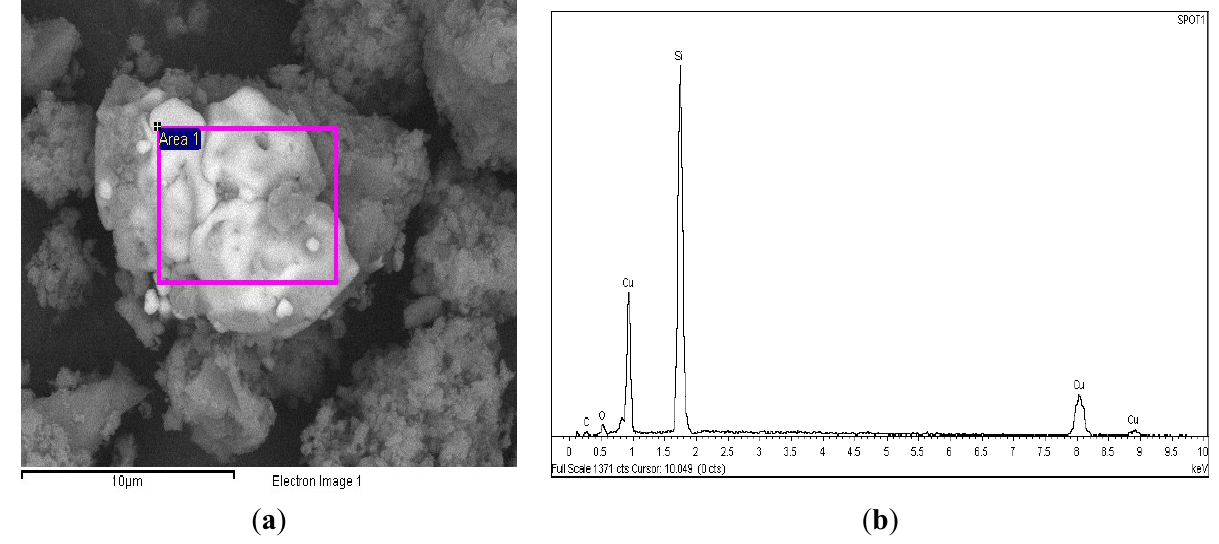
Figure 3. SEM-EDX analysis for a typical Cu-PS powder sample. ( a ) SEM micrograpgh; ( b ) EDX spectrum of the boxed area in ( a